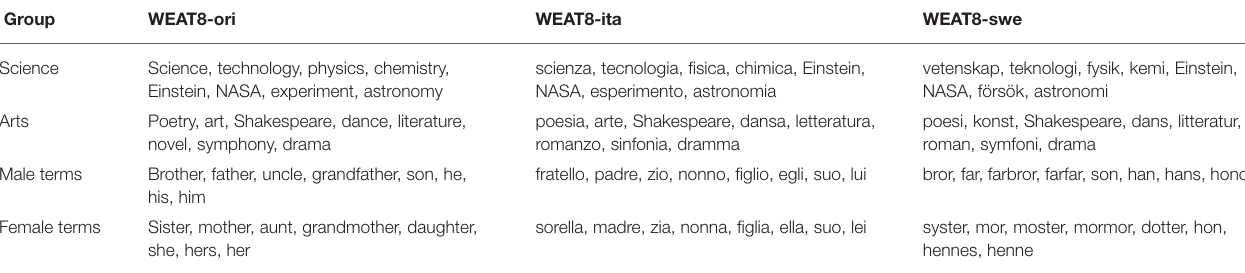
TABLE 5 | The terms from the original WEAT8 experiment (Caliskan et al., 2017) and our adaptations/translations to Italian and Swedish. Group